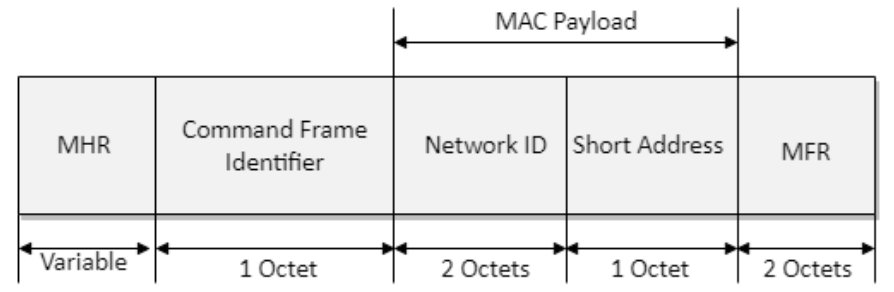
Figure 12. The format of the proposed handover-request frame.